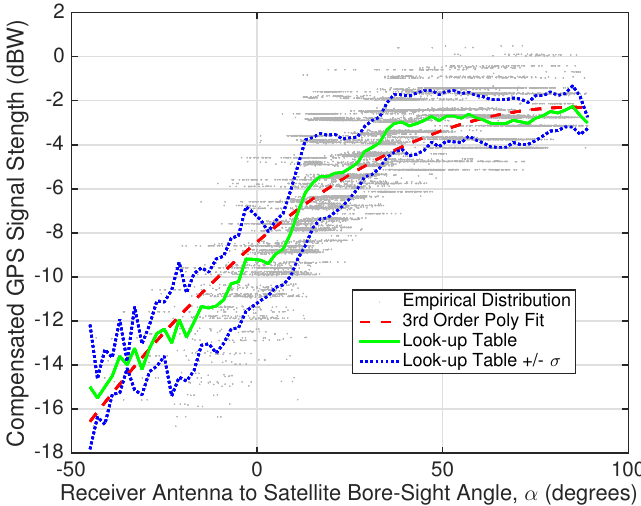
Figure 2. Empirical curve and calibration curves determined for mapping global positioning system (GPS) signal strength measurements to the antenna bore-sight angle, α .